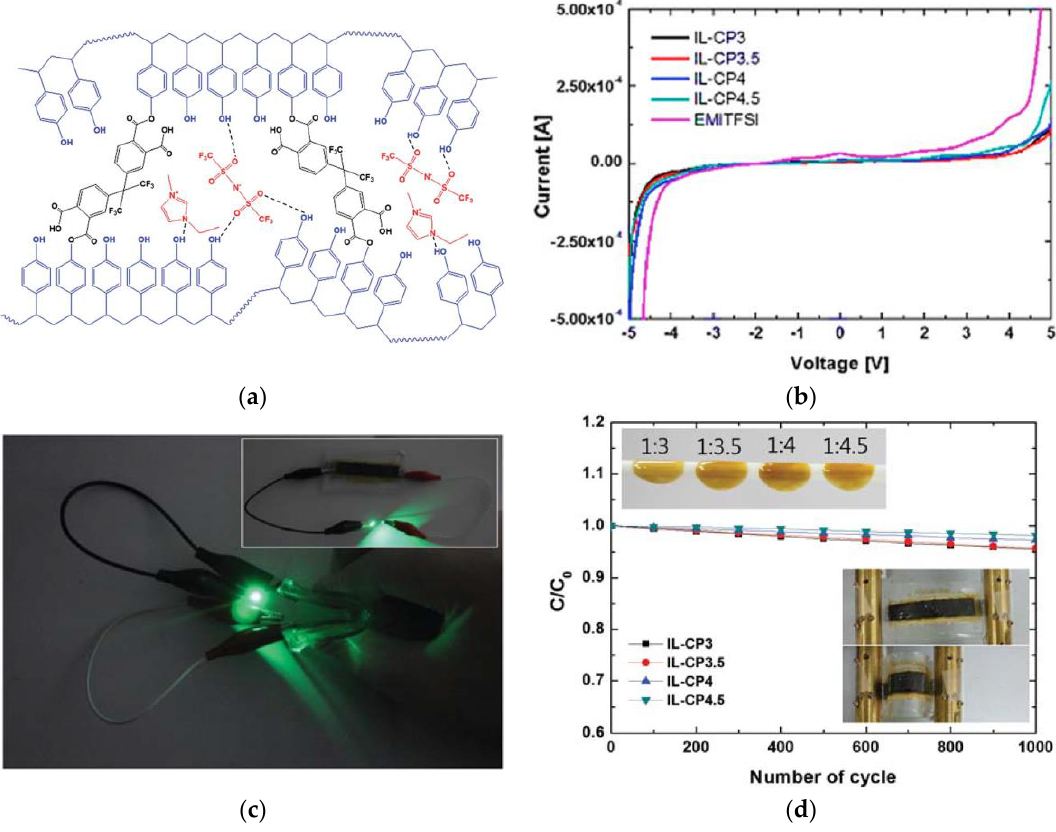
Figure 15. ( a ) Estimated structure of solid electrolyte; ( b ) linear sweep voltammogram for [EMI][TFSI] and solid electrolyte; ( c ) flexibility of solid electrolyte and bending performance of SCs with solid electrolyte for 1000 cycles; ( d ) photograph of a green light-emitting diode (LED) powered by a single SC with a solid electrolyte. Reprinted 2015 from [60] with permission from IOP